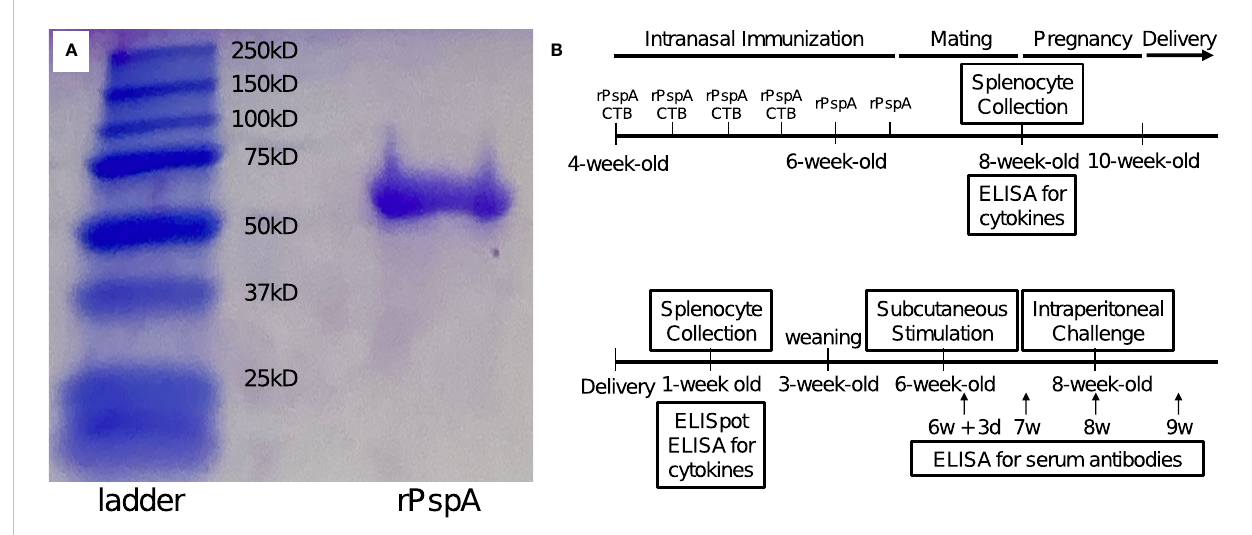
FIGURE 1 SDS-PAGE of rPspA and schematic of the experiment. (A) SDS-PAGE of rPspA after puri fi cation. Quanti fi ed rPspA was puri fi ed by nickel af fi nity chromatography. The appropriate size of the product and a single band were con fi rmed by SDS-PAGE. (B) Schedule from immunization of adult mice until experiments. Four-week-old female mice were immunized intranasally twice a week with rPspA 1 m g and CTB for the fi rst two weeks and only rPspA for the last week. Control mice were given CTB only in the fi rst two weeks and only saline during the last week. After immunization, the female mice were mated with male mice. Three weeks after mating, the offspring were obtained. Splenocytes of week-old offspring were analyzed for the ability to produce antibodies and cytokines. Subcutaneous stimulation of rPspA was performed at four weeks of age. The serum levels of anti-PspA antibodies were analyzed 3, 7, 14 and 21 days after the stimulation. At two weeks after the stimulation with rPspA (at six-week-old), offspring were intraperitoneally challenged with S. pneumoniae